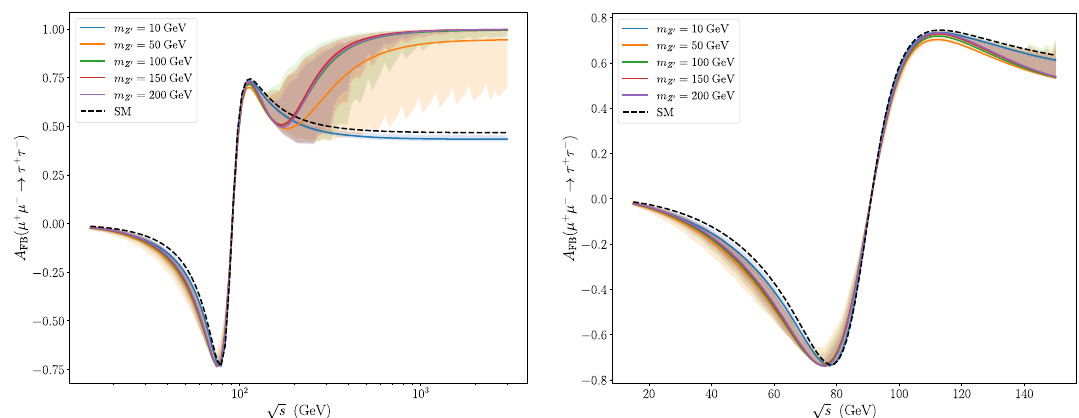
√ s for different values of m Z (cid:2) . On the left panel, general view for √